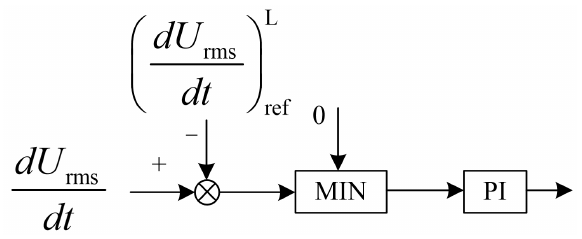
Fig. 7. Diagram of transient low voltage suppression module.